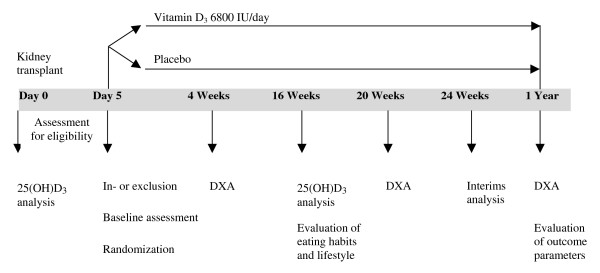
Study procedures.